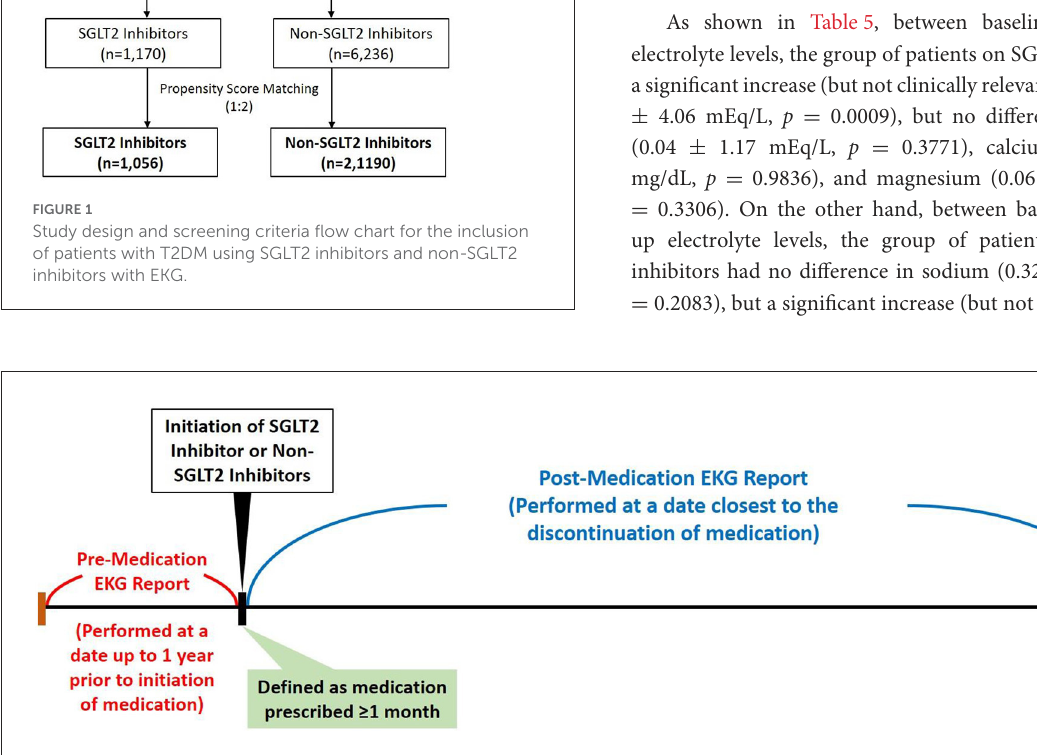
FIGURE2 Enrollment criteria for patients with